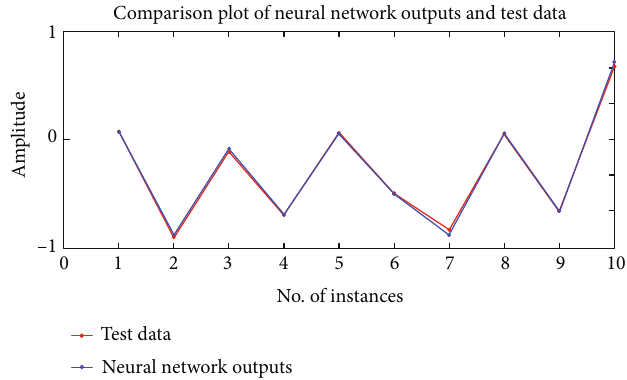
Figure 14: Results comparison of the neural network and test